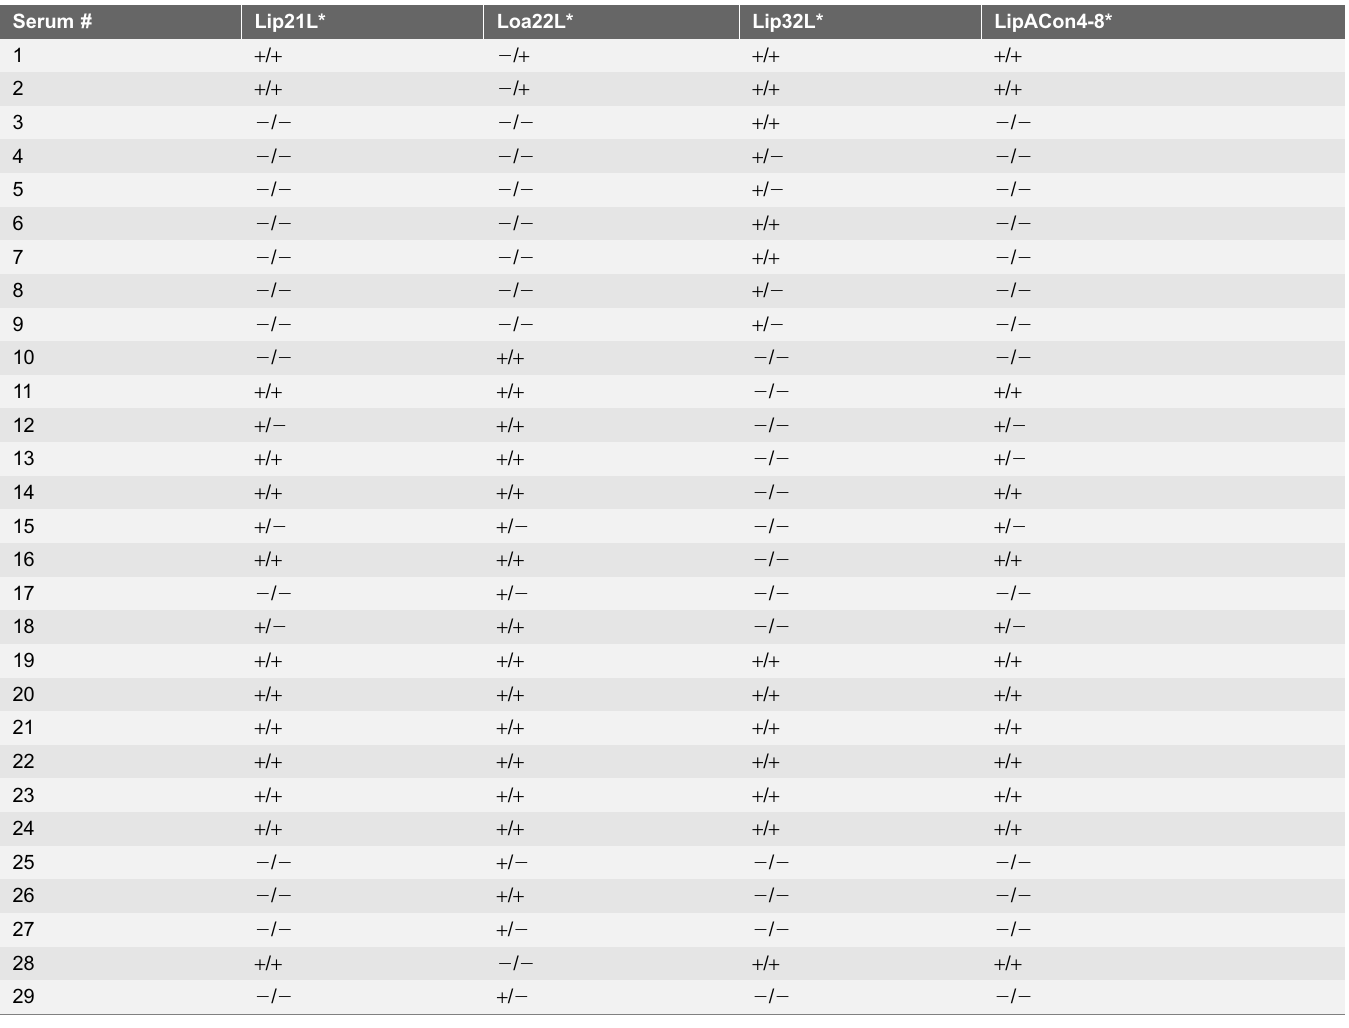
Table 6. The ELISA and Western blot analysis of the 29 samples that were MAT negative, but ELISA positive to one to four of these antigens. Serum # Lip21L* Loa22L*